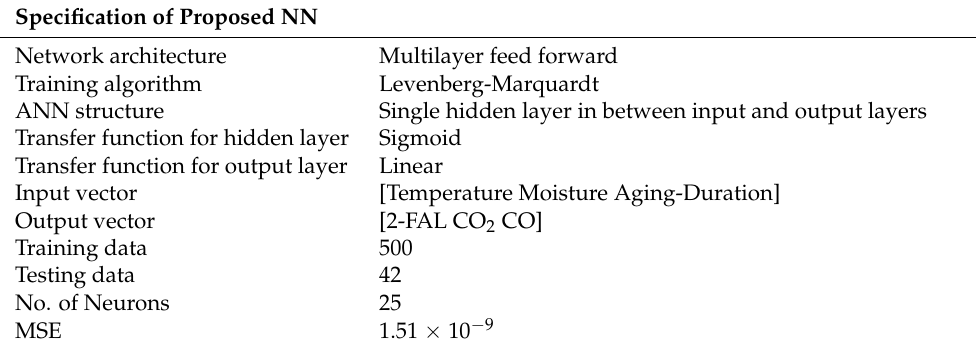
Table 1. Specification of the proposed ANN